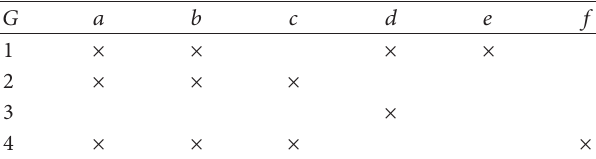
Table 1: A formal context (𝐺,𝑀, 𝐼) . Table 2: A formal context (𝐺, 𝑀, 𝐼 𝑐 ) .